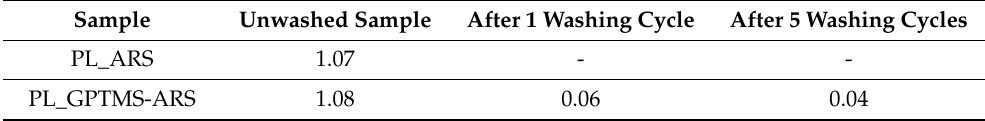
Table 3. K/S of the treated polyester fabrics at the peak maximum as reported in the footnote ( 1 ).